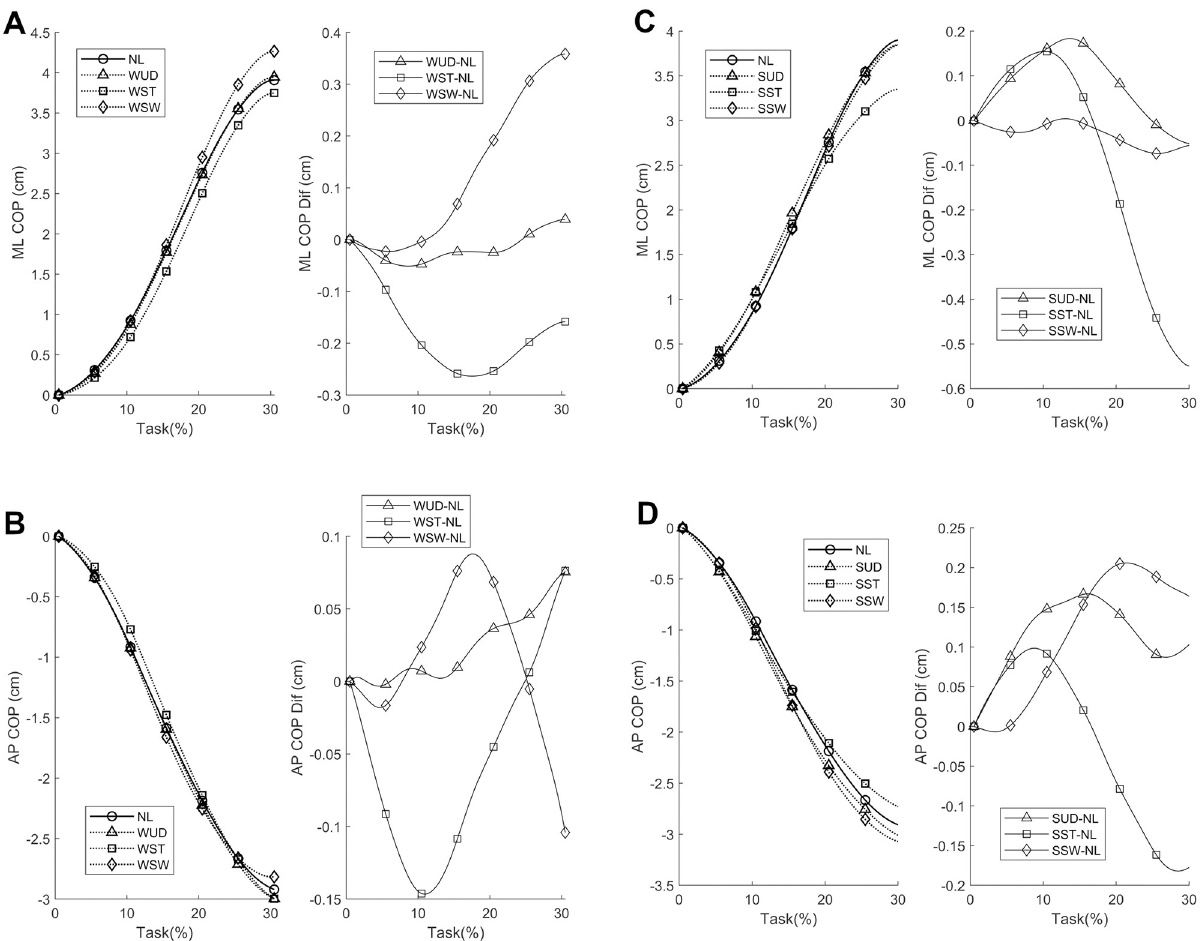
Fig 2. Average medial-lateral (ML) and anterior-posterior (AP) center of pressure (COP) anticipatory postural adjustments (APA) phase components, with additional weight positioned at the waist (A and B, respectively) and shoulder (C and D, respectively) and their corresponding differences compared to the no-load (NL) condition. WUD: weight uniformly distributed at the waist; WST: weight positioned at the waist on the stance foot side; WSW: weight positioned at the waist on the swing foot side, SUD: weight uniformly distributed at the shoulder; SST: weight positioned at the shoulder on the stance foot side; SSW: weight positioned at the shoulder on the swing foot side.